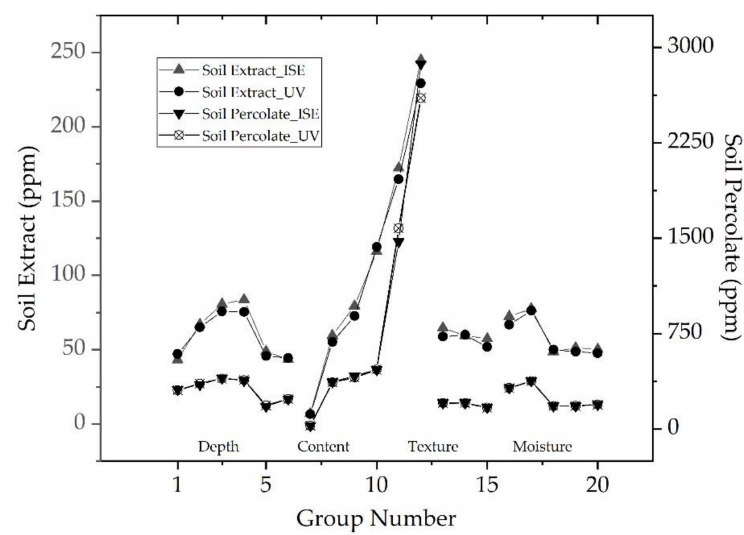
Figure 6. In-situ and laboratory monitoring of soil NO 3 − -N with the GCE / AuNPs / PPy(NO 3 − ) ISE and UV-VIS (Supplementary Materials S2).